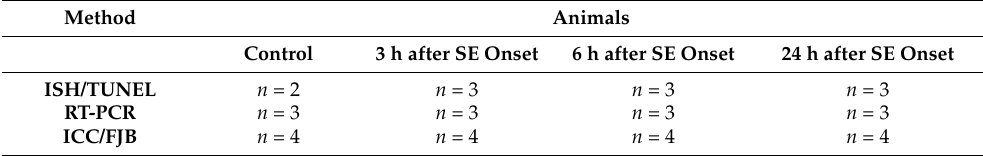
Table 2. Experimental